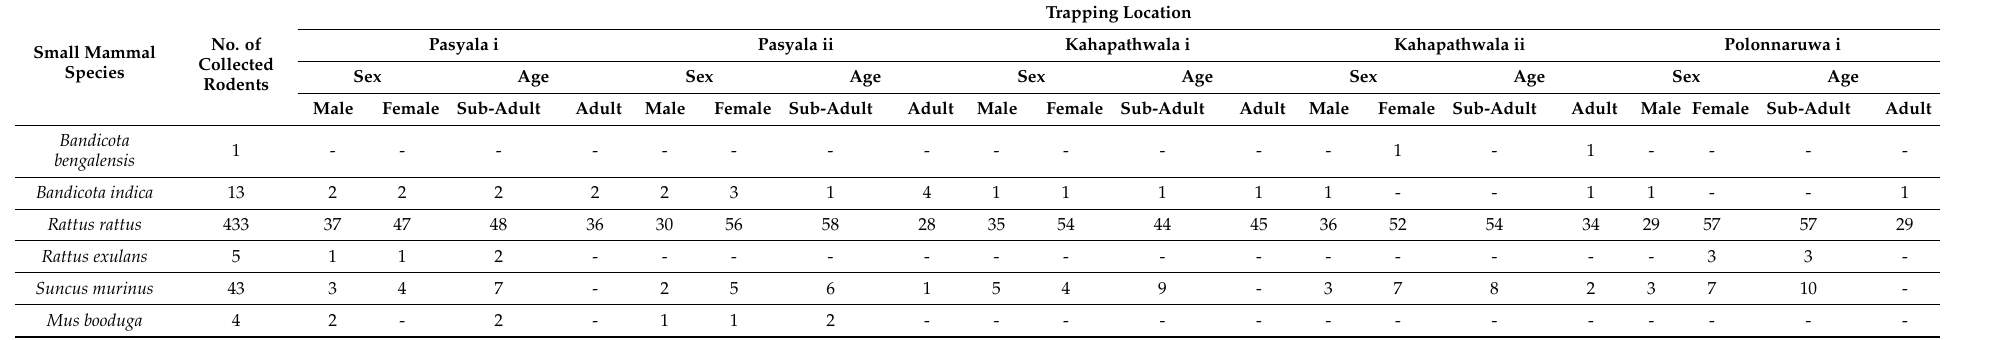
Table 2. Number of small mammal species collected at different study sites from Sri